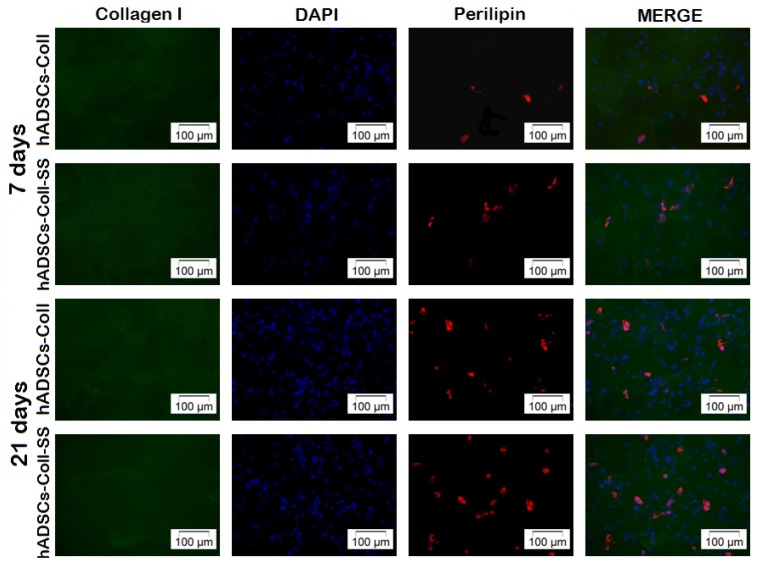
Fluorescence microscopy micrographs revealing perilipin expression after 7 and 21 days of adipogenesis in both hADSCs-Coll and hADSCs-Coll-SS constructs.